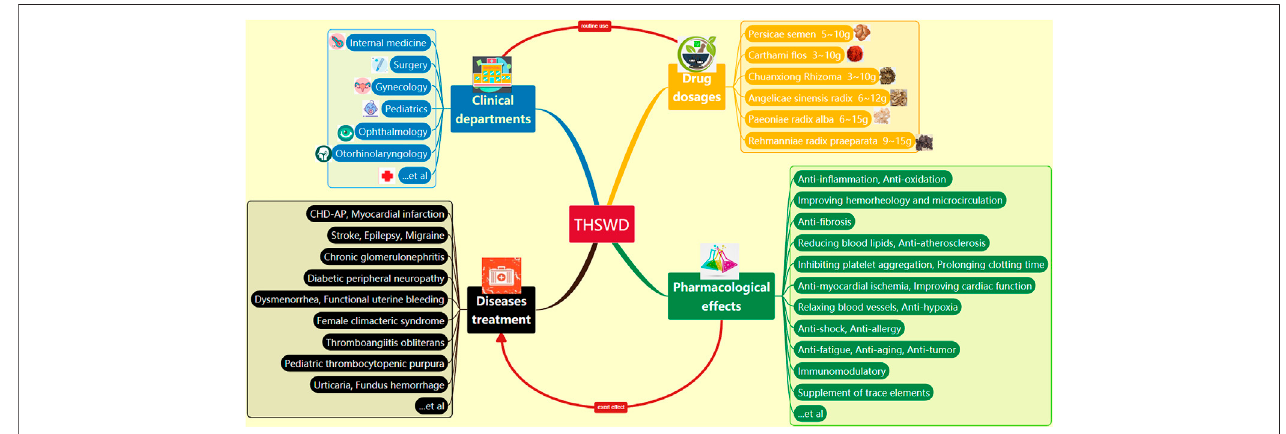
FIGURE 1 | Clinical applications and pharmacological effects of THSWD (THSWD: Tao Hong Siwu decoction).